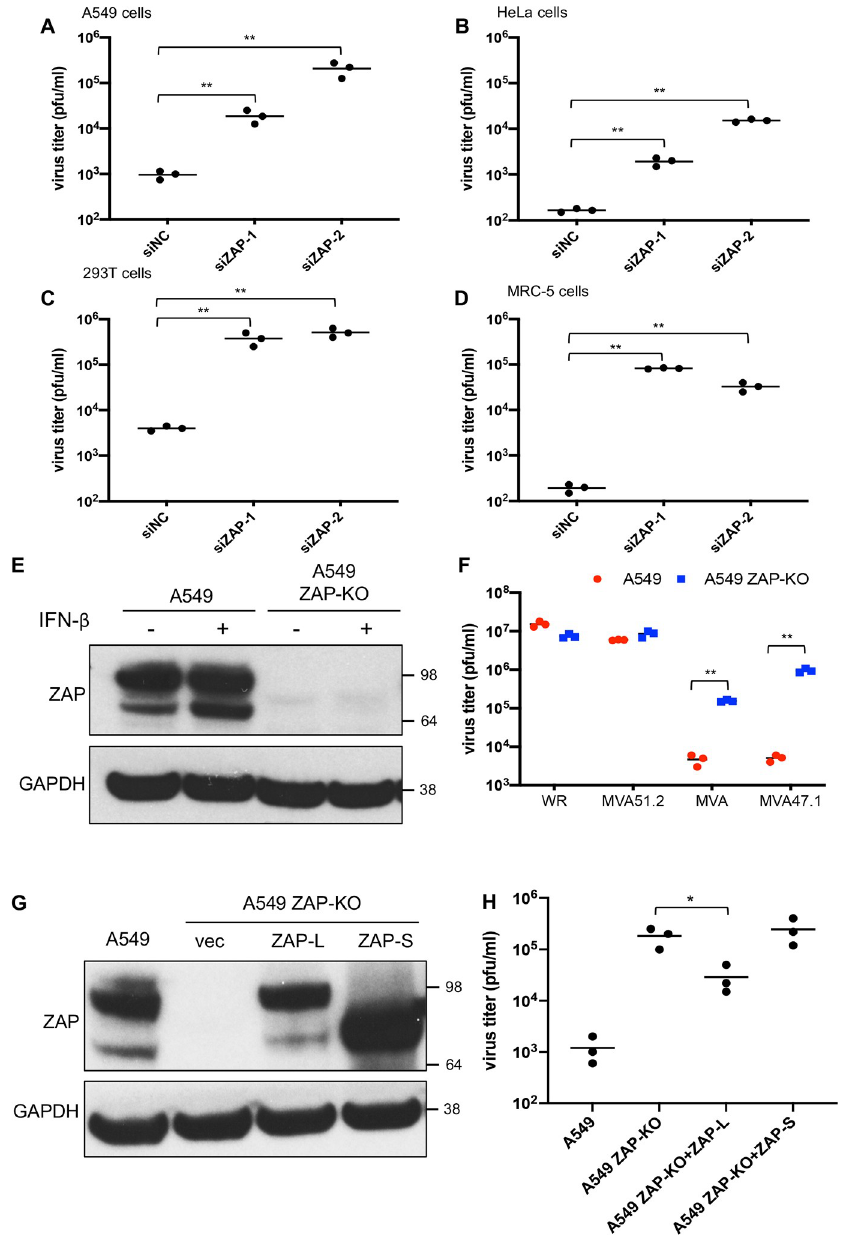
Fig 2. ZAP is a restriction factor for MVA in human cells. (A-D) Human A549, HeLa, 293T and MRC-5 cells were transfected in triplicate with siRNA for 48 h and then infected with MVA 47.1-GFP at 0.01 PFU/cell. Cells were collected after 48 h and virus titers determined by plaque assay on CEF. Virus titers from each infection are shown as dots, and the bar represents the mean value. siNC: non-targeting negative control siRNA. ( E ) A549 and A549 ZAP-KO cells were left untreated or treated with interferon- β for 24 h. Cell lysates were analyzed by SDS-PAGE and Western blotting with anti-ZAP antibody. GAPDH was used as a loading control. Numbers on the right represent the electrophoretic positions and masses of marker proteins in kDa. ( F ) A549 and A549 ZAP-KO cells were infected in triplicate with the indicated viruses at 0.01 PFU/cell. Cells were collected after 48 h and virus quantitated by plaque assay on CEF. Virus titers from each infection are shown as dots and the bar represents the mean value. ( G ) A549 cells and A549 ZAP-KO cells stably expressing ZAP-L, ZAP-S or vector control (vec) were lysed and proteins resolved by SDS-PAGE and Western blotting with anti-ZAP antibody. ( H ) Cell lines described in G were infected with MVA 47.1-GFP at 0.01 PFU/cell and cells were harvested at 48 h and virus titers determined by plaque assay on CEF. Virus titers from each infection are shown as dots and the bar represents the mean value. Statistics: � p < 0.05; �� p < 0.01 by two-sided Student’s t-test.